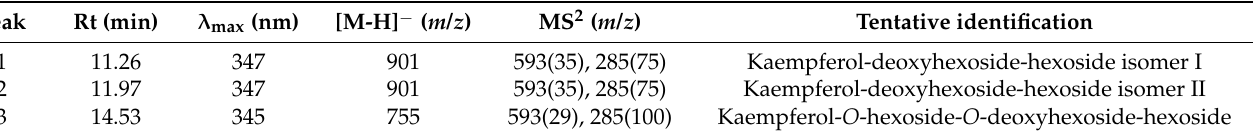
Table 5. Retention time (Rt), wavelengths of maximum absorption in the visible region ( λ max ), mass spectral data and identification of the phenolic compounds present in the Pardina lentil “Lenteja de Tierra de Campos”. Peak Rt